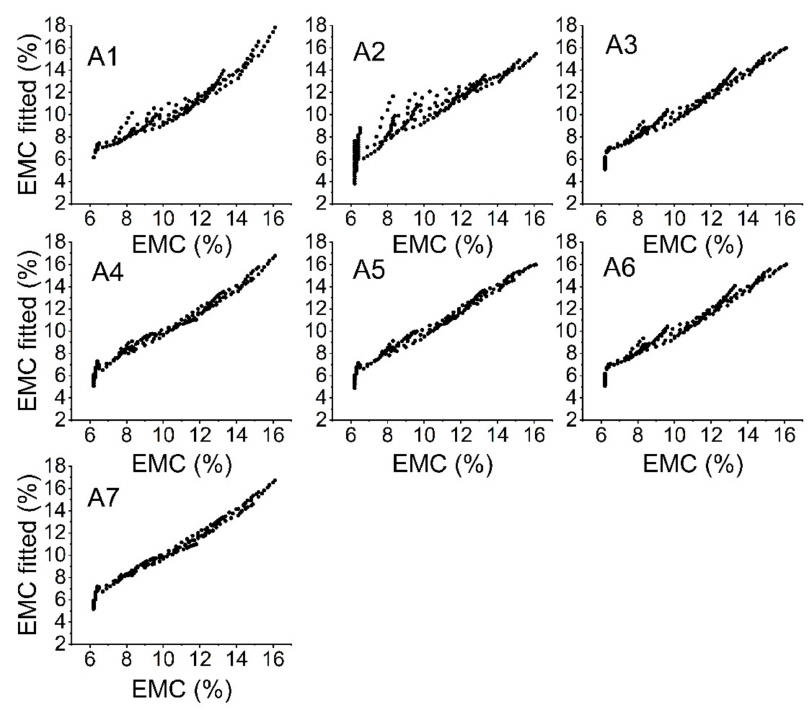
Figure A1. Seven multiple regressions tried for the equilibrium moisture content